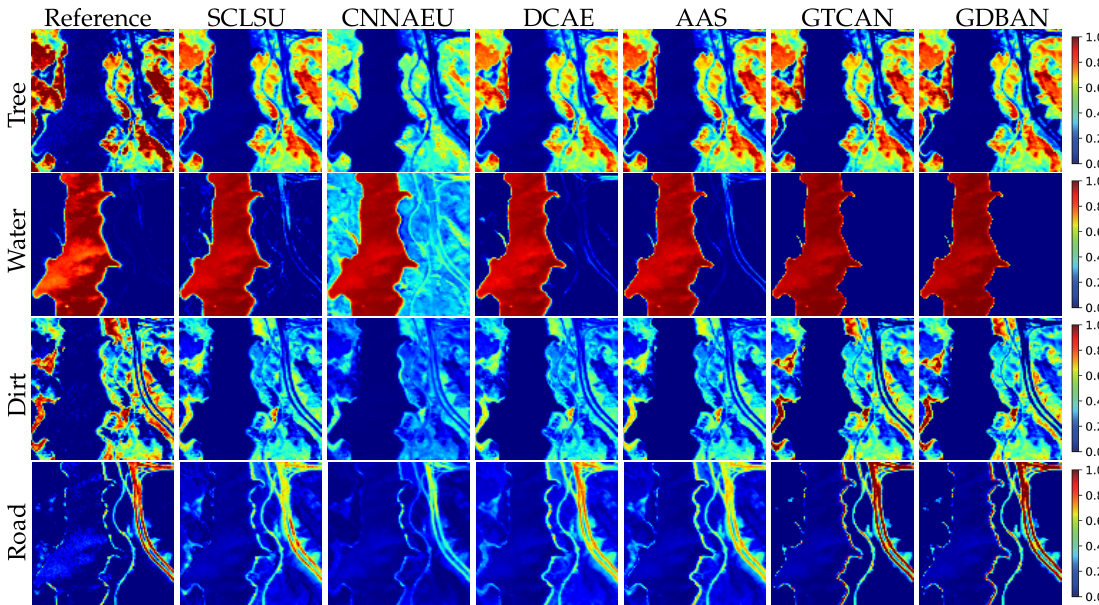
Figure 8. Reference and estimated abundance maps on Jasper Ridge data by different methods.